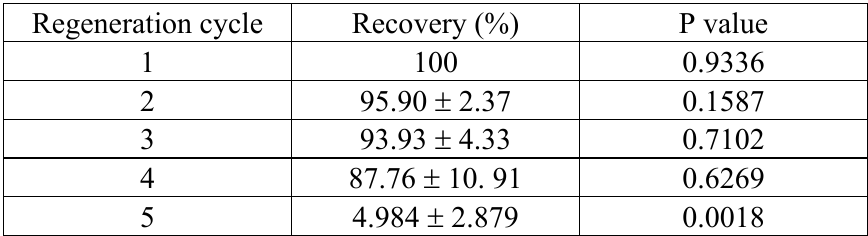
Table 2. Recovery rate of regenerated